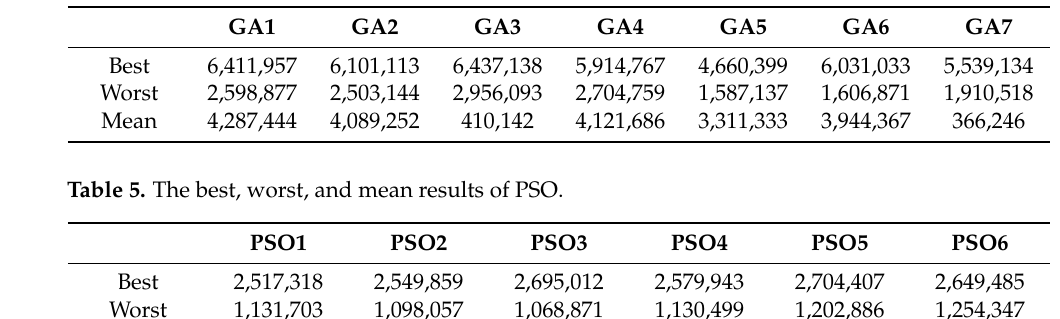
Figure 8. Boxplots of GA and PSO for solving the robot placement and motion planning problem. Table 4. The best, worst, and mean results of GA.